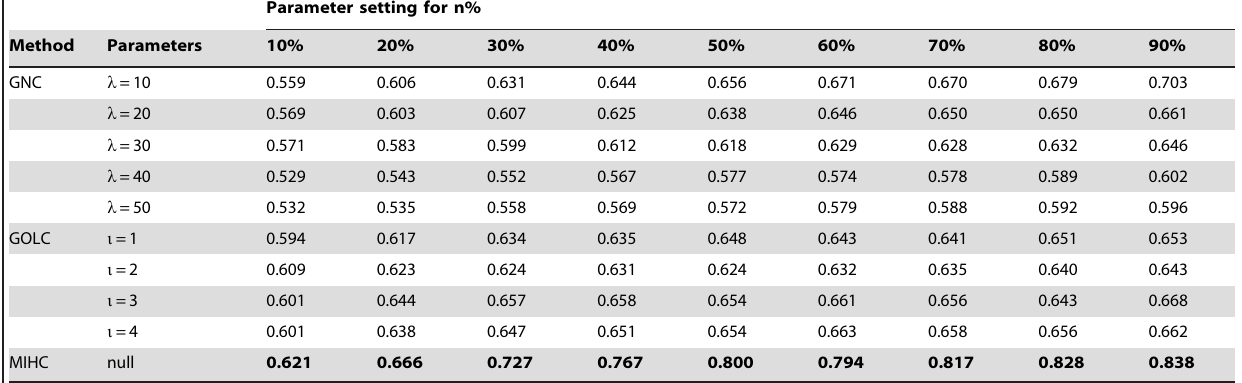
Parameter setting for n%